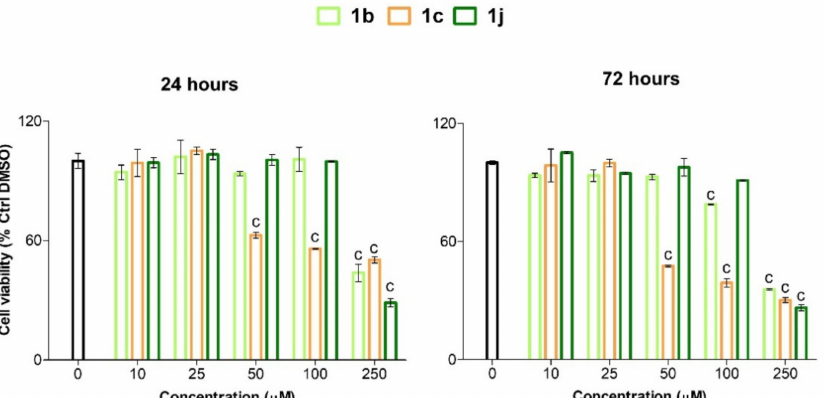
Figure 7. Cell metabolic activity of human skin fibroblasts (HFF-1) in the presence of increasing concentrations of compounds 1b , 1c , and 1j . Data shown are the means ± S.D. of three replicates and are expressed as percentages of cultures in the presence of vehicle (DMSO) set as 100%. a = p < 0.01; b = p < 0.001; c = p < 0.0001 between compounds and DMSO.